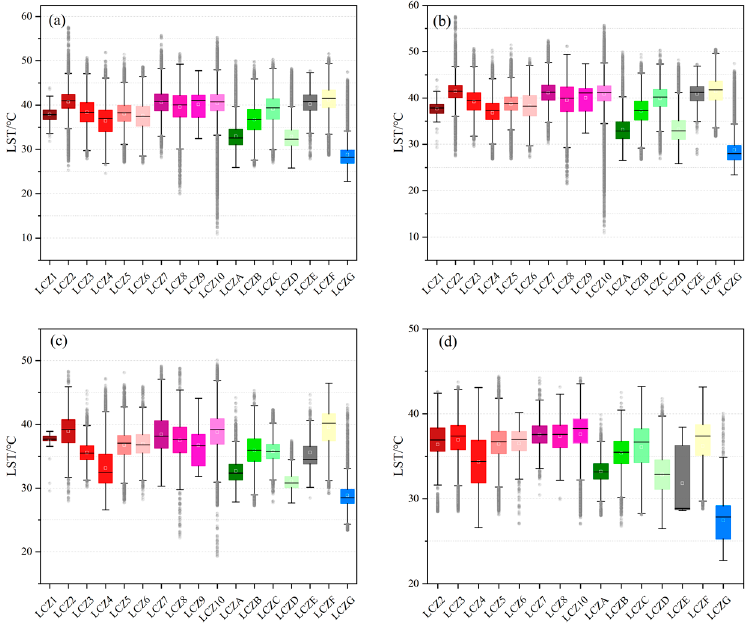
Figure 8. LCZ and LST box line diagram: ( a ) the total study area; ( b ) Urumqi city; ( c ) Changji city; ( d ) Wujiaqu city.